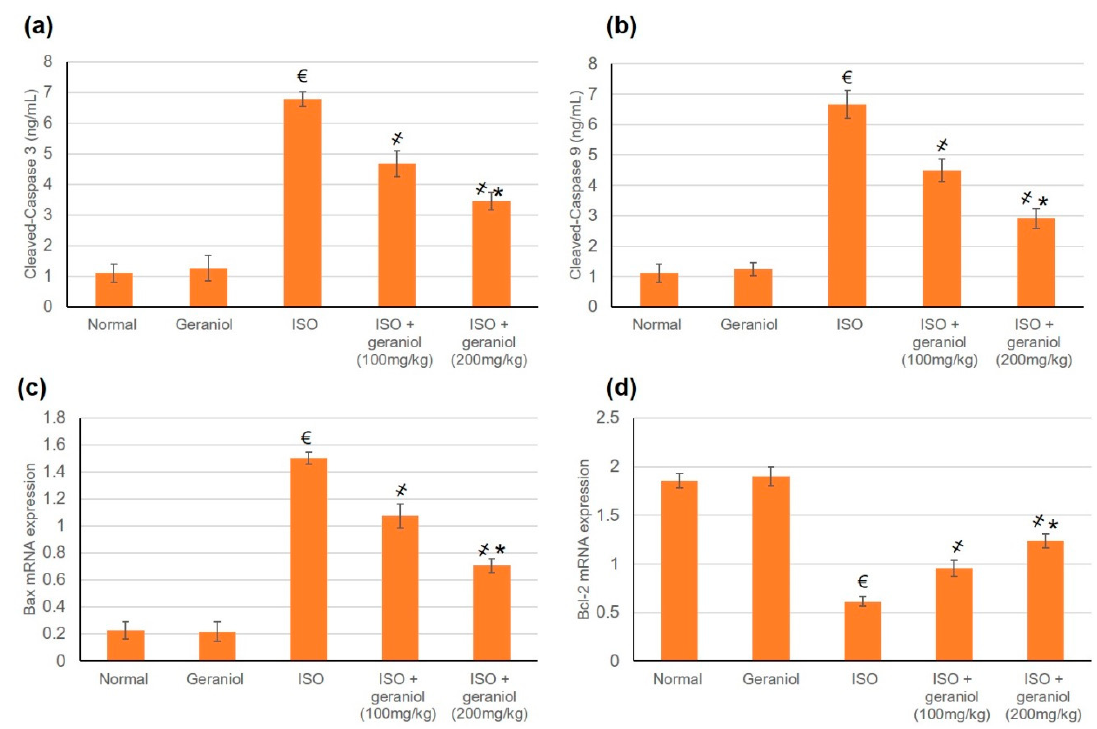
Figure 7. Geraniol pretreatment (100 or 200 mg/kg) partially ameliorated the pro-apoptotic profile observed in isoproterenol (ISO)-induced myocardial infraction (MI). Geraniol ameliorated the protein expression levels of ( a ) cleaved caspase-3 and ( b ) cleaved caspase-9, as well as the mRNA expression levels of ( c ) Bax and ( d ) Bcl2. All values were stated as mean ± SD ( n = 6). € , p < 0.05 compared to the normal group; ҂ , p < 0.05 compared to the ISO-induced MI group; *, p < 0.05 compared to the ISO + geraniol (100 mg/kg) group. Comparisons done using one-way ANOVA followed by Tukey-Kramer post-hoc test.